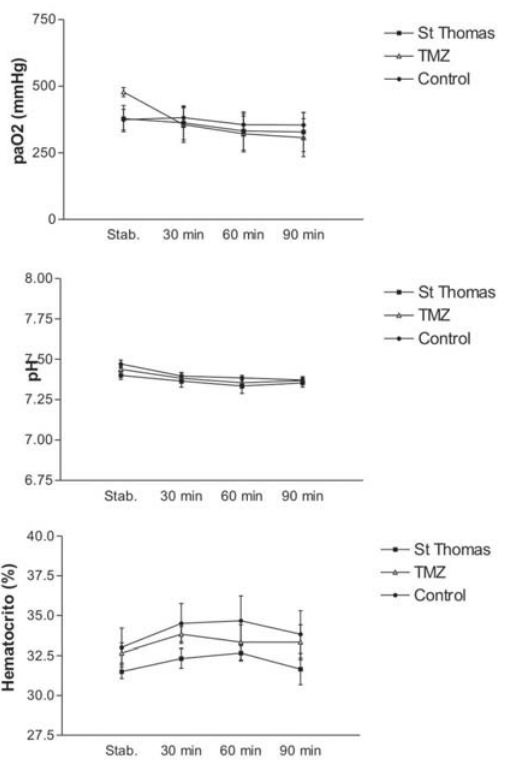
Fig. 5 - Pressão parcial de oxigênio (acima), pH (médio) e hematócrito (abaixo) dos animais suporte ao longo do procedimento. Dados apresentados como média e dois erros padrão da média (EPM) (n=6) em cada grupo. Os dados mostram estabilidade do modelo desde a estabilização até os 90 minutos de reperfusão total (período total de 180